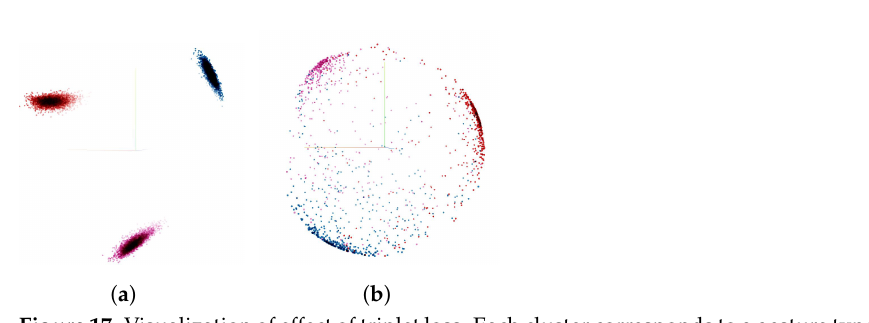
Figure 17. Visualization of effect of triplet loss. Each cluster corresponds to a gesture type. ( a ) Training set embedding vectors visualized in 3-dimensional space with PCA. ( b ) Test set embedding vectors visualized in 3-dimensional space with